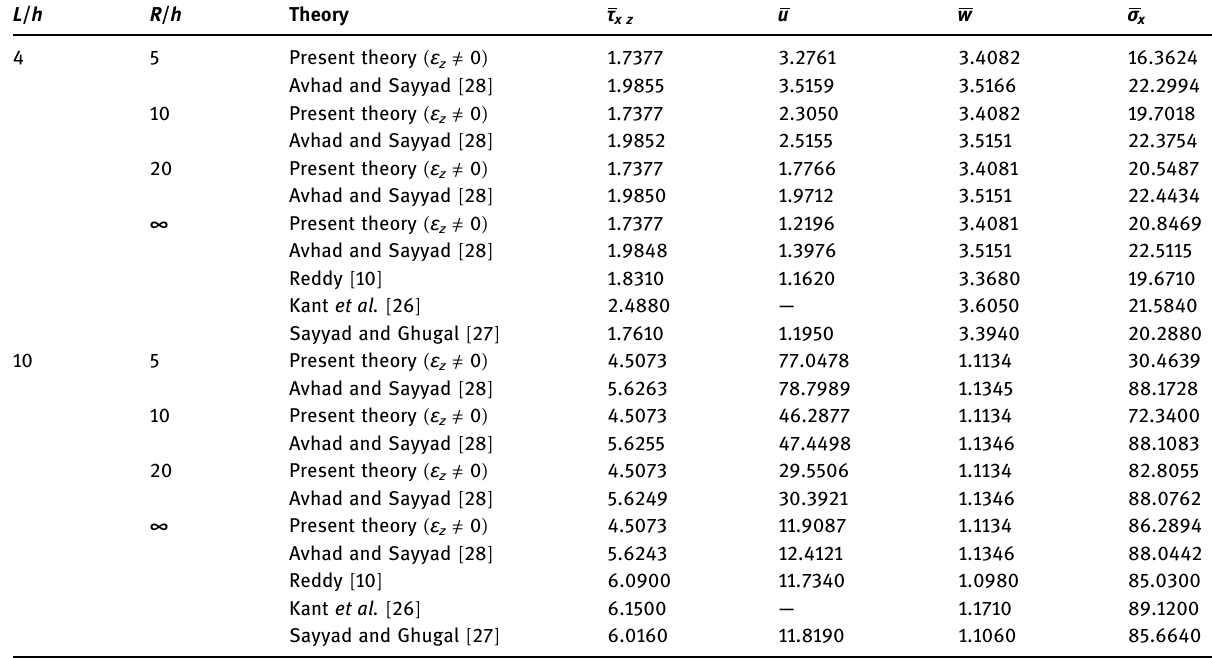
Table 4: Assessment of non - dimensional transverse shear stresses, axial displacements, transverse displacements, and axial bending stresses for symmetric three layered ( 0°/90°/0° ) composite